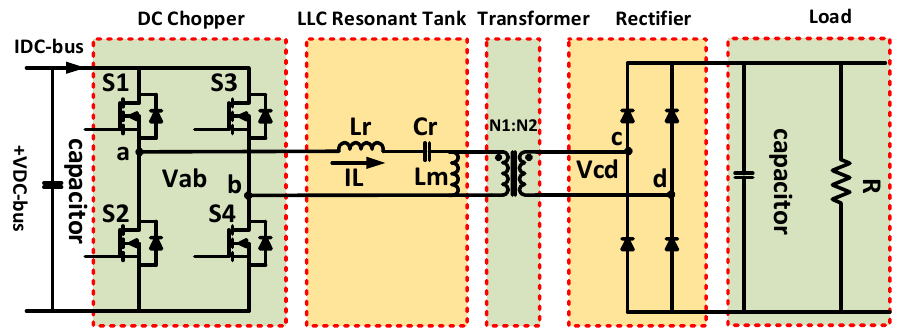
Figure 1. The full bridge LLC resonant converter.